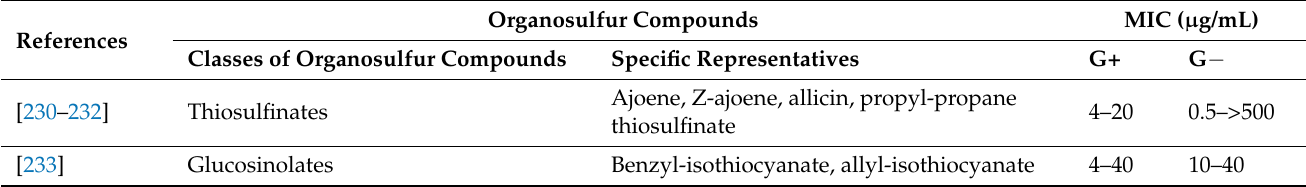
Table 8. The minimum inhibitory concentrations of selected organosulfur compounds against gram-positive and gram- negative